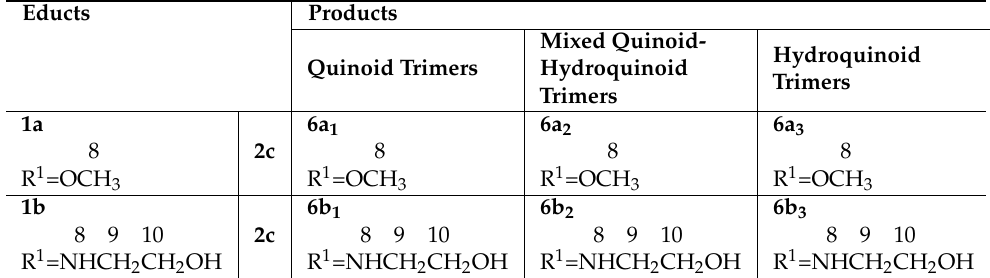
Figure 3. Laccase-mediated reactions of 2,5-dihydroxybenzene derivatives ( 1a, 1b ) with dapsone ( 2c ) for the synthesis of heterotrimers produced as shown in Table 3. (R 1 = OCH 3, NH(CH 2 ) 2 OH). Table 3. Heterotrimers produced by laccase-mediated reactions of 2,5-dihydroxybenzene derivatives ( 1a, 1b ) with dapsone ( 2c